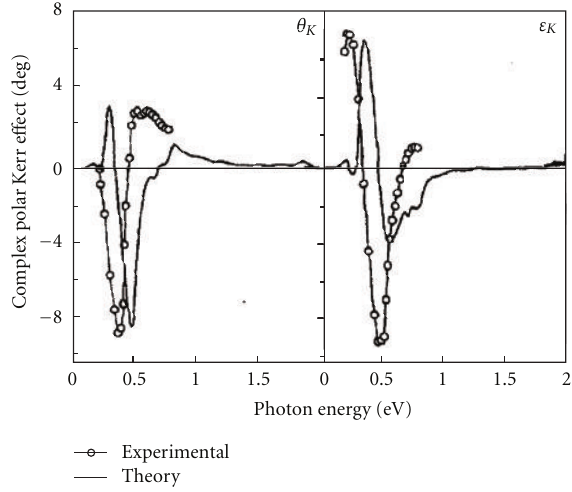
Figure 43: Theoretical [276] and experimental [257] Kerr angle ( θ K ) and Kerr ellipticity ( ε K ) spectrum of CeBi. The theoretical spectrum (solid curve) was calculated using the LSDA+ U approach with U =